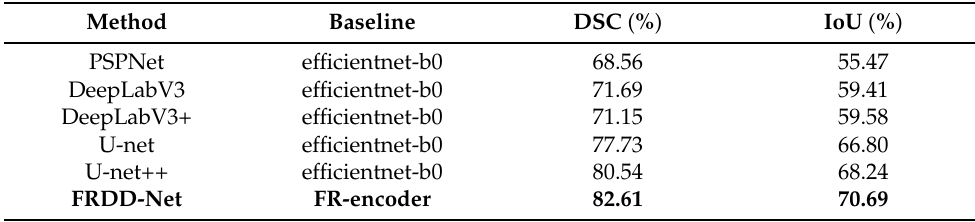
Figure 5. Qualitative comparison of cross-dataset test results produced by FRDD-Net and other methods (DeepLabeV3, DeepLabeV3+, Unet, Unet++, and PSPNet) against ground truth (GT). ( a – f ) are partial segmentation results. Table 2. Overall quantitative comparison results of cross-dataset test in terms of dice similarity coefficients (DSCs) and intersection over union